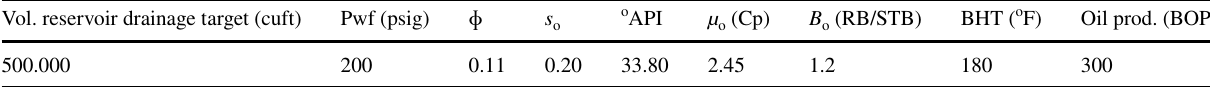
Table 1 Reservoir properties data Vol. reservoir drainage target (cuft)